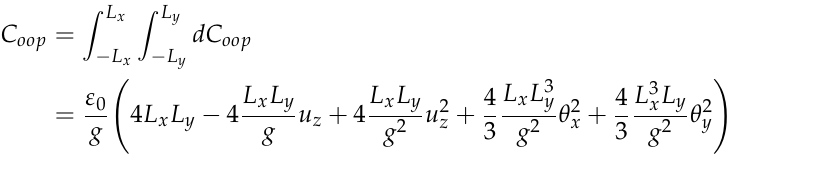
Figure 6. Scheme of an out-of-plane capacitor as a function of u z , θ x , θ y . The total out-of-plane capacitance as a function of u z , θ x , θ y can be then computed by integrating Equation (4) over the electrode area defined by the dimensions L x and L y